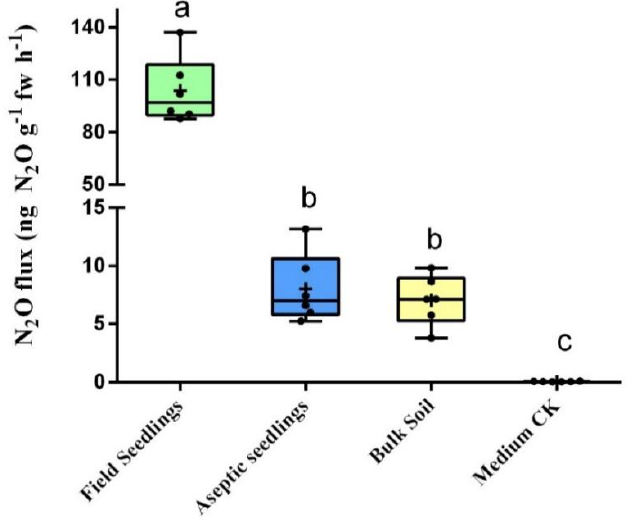
Figure 2. The N 2 O flux from differently treated soybean seedlings and bulk soil (45% moisture), means (mean ± SE, n = 5) followed by the same letter are not significantly different at p < 0.05.